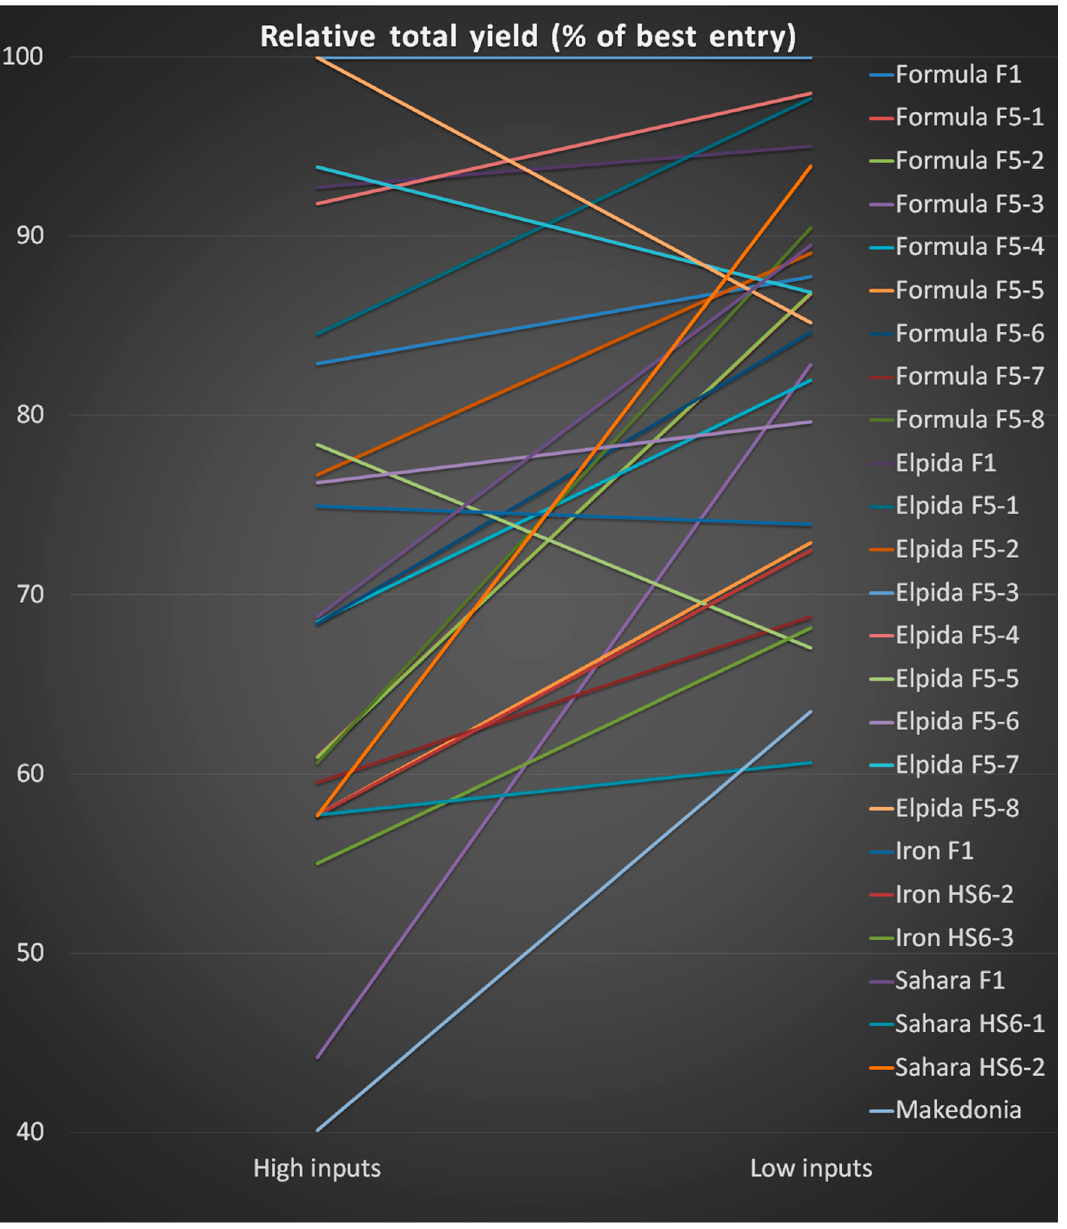
Figure 2. Relative total yield (as % of the best entry) of F 1 hybrids and recombinant inbred lines in two different (high- and low-input) farming systems.